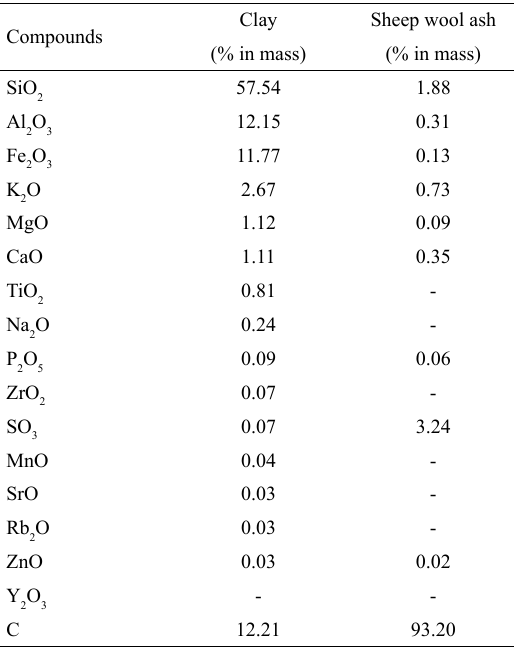
Table 2. Results obtained in the chemical analysis of the clay and ash.